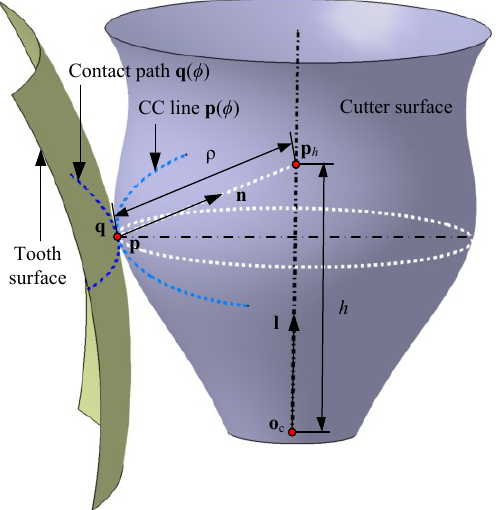
Figure 2. The tangency condition between the cutter envelope surface and tooth surface. With both models of tooth surface and contact path, the tool path planning for five-axis flank milling is implemented with two steps. First, the tool path strategy based on the necessary conditions is used to make the cutter envelope surface tangent to the designed surface along the contact path. Second, cutter orientations are optimized to obtain the minimal geometric deviations of the contact